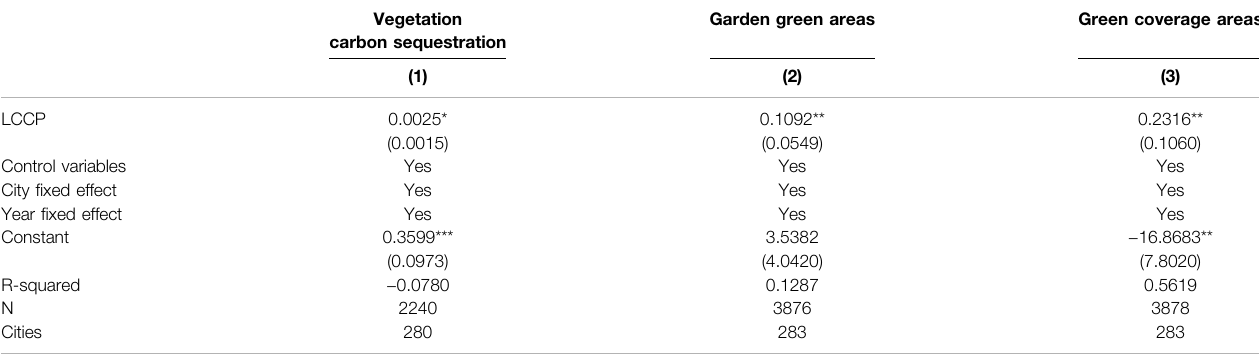
TABLE 5 | LCCP and carbon absorption.